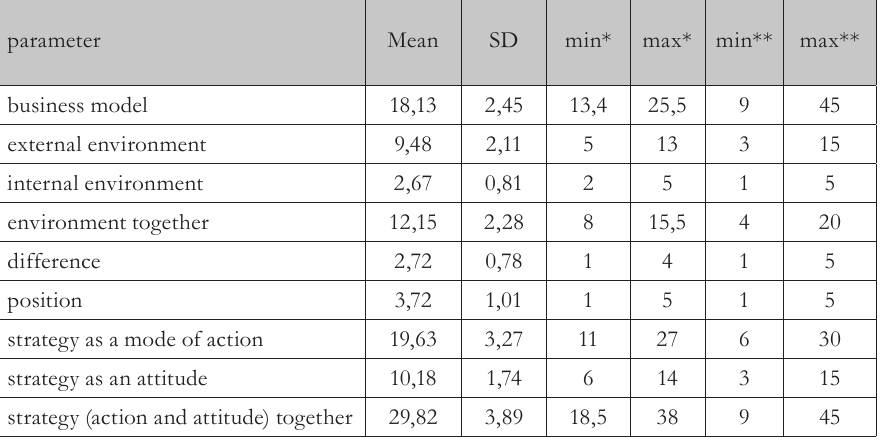
Tab. 1 Basic statistics data on the examined